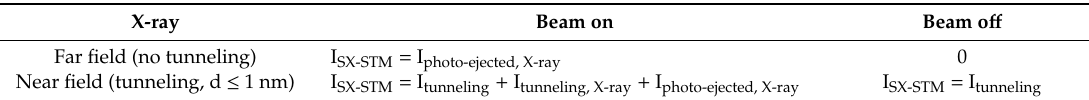
Table 1. Synchrotron X-ray Scanning Tunneling Microscopy (SX-STM) experimental regimes and corresponding tunneling current